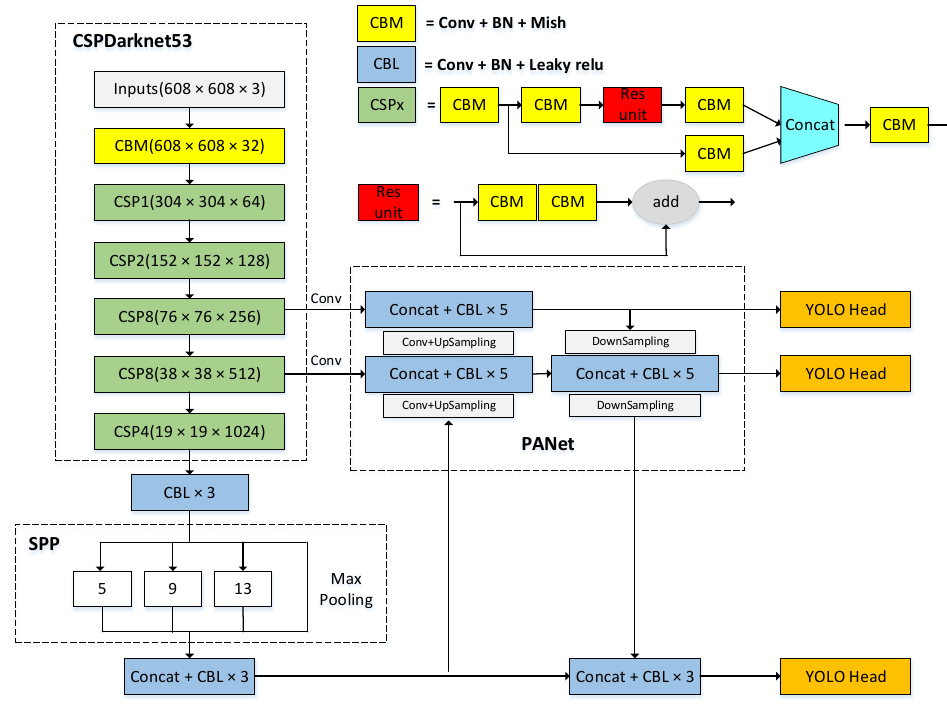
Figure 1. YOLOv4 model